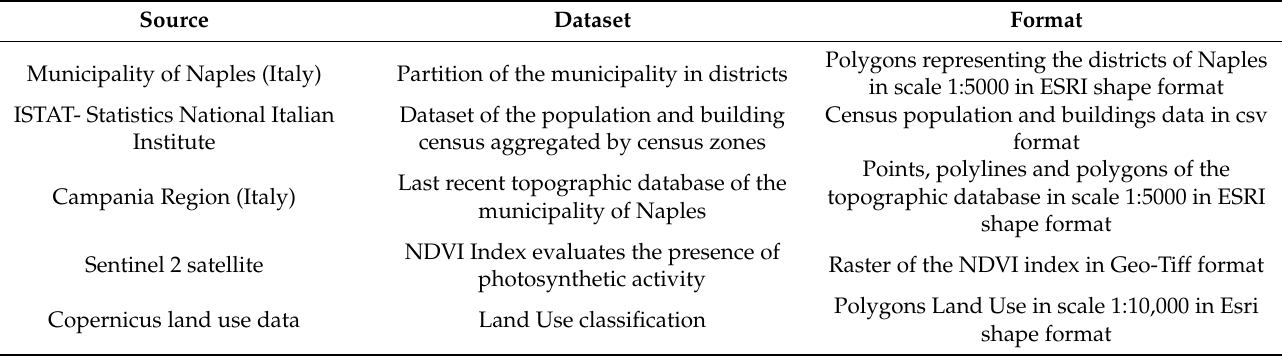
Table 2. Source datasets used to implement the